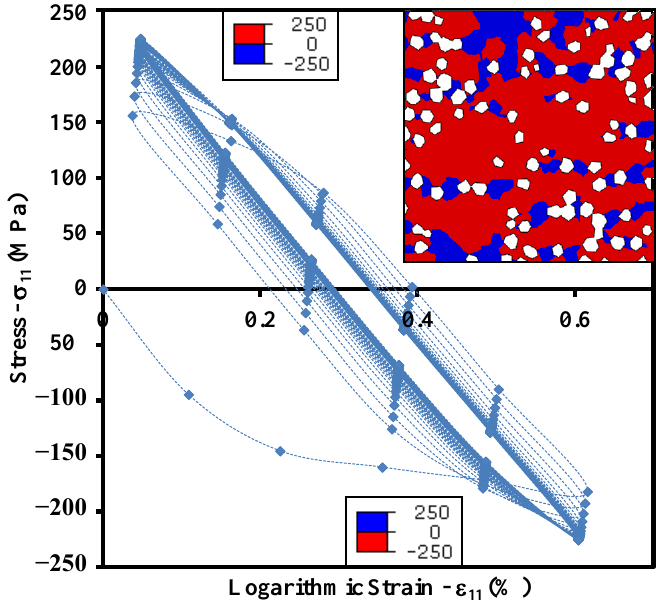
Figure 9. Case 4: Peak stress vs. logarithmic strain response to the applied thermal cyclic loading and zones of tension and compression within the Cu-matrix.